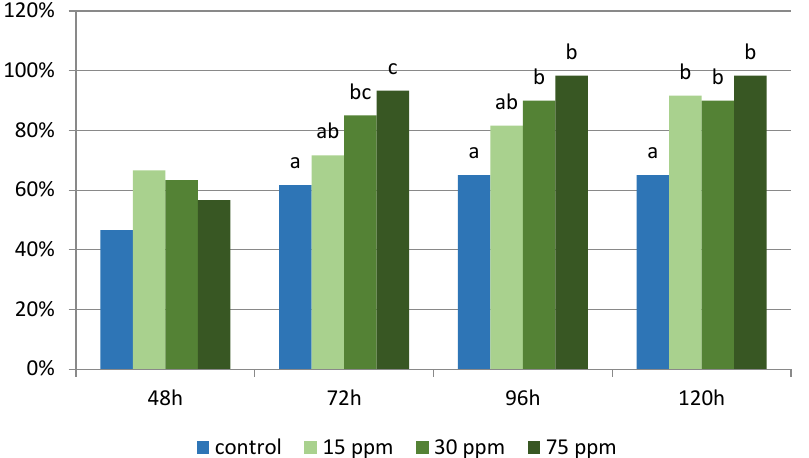
Figure 5. Germination of tomato seeds in culture after application of different concentrations of silver nanoparticles (75 ppm, 30 ppm and 15 ppm). The control sample was treated with sterile water. Treatments were compared using analysis of variance and Fisher’s LSD test for each term separately. Parameters in columns denoted with the same letters (a. b. c.) do not differ statistically at the confidence level of p < 0.05. Lack of letters means no statistically significant differences.